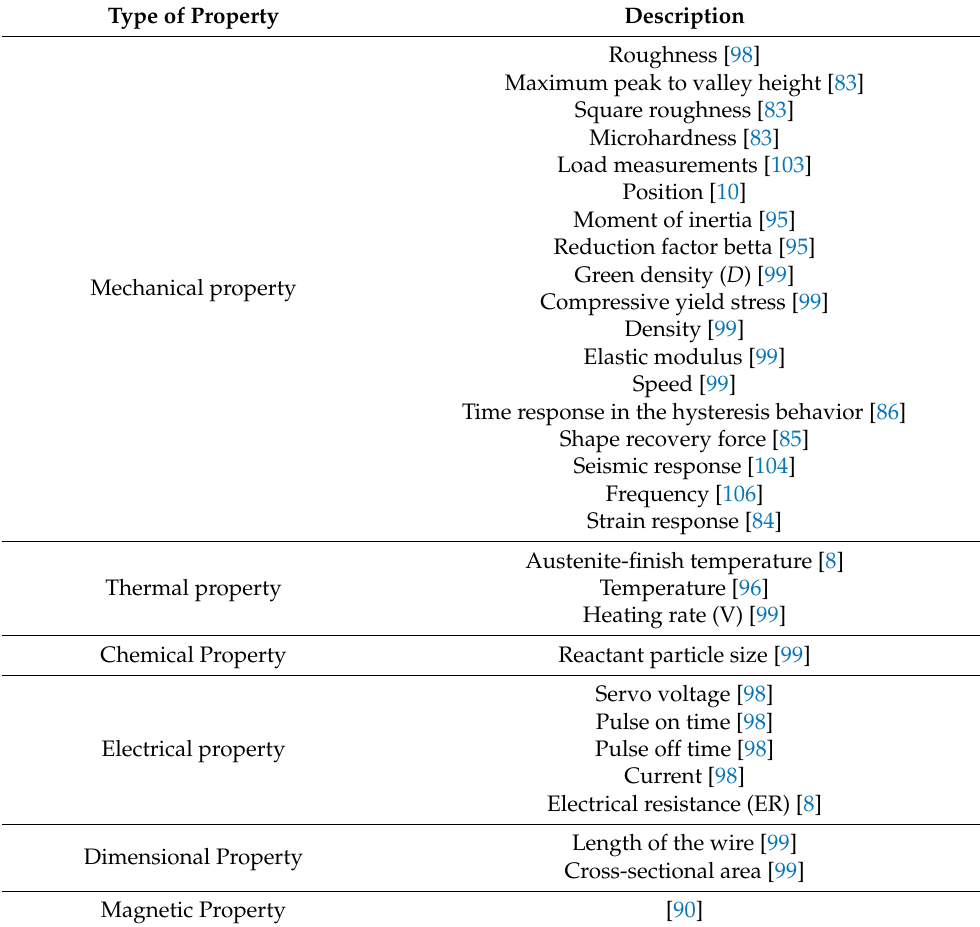
Table 2. Classification of SMA’s application concerning its